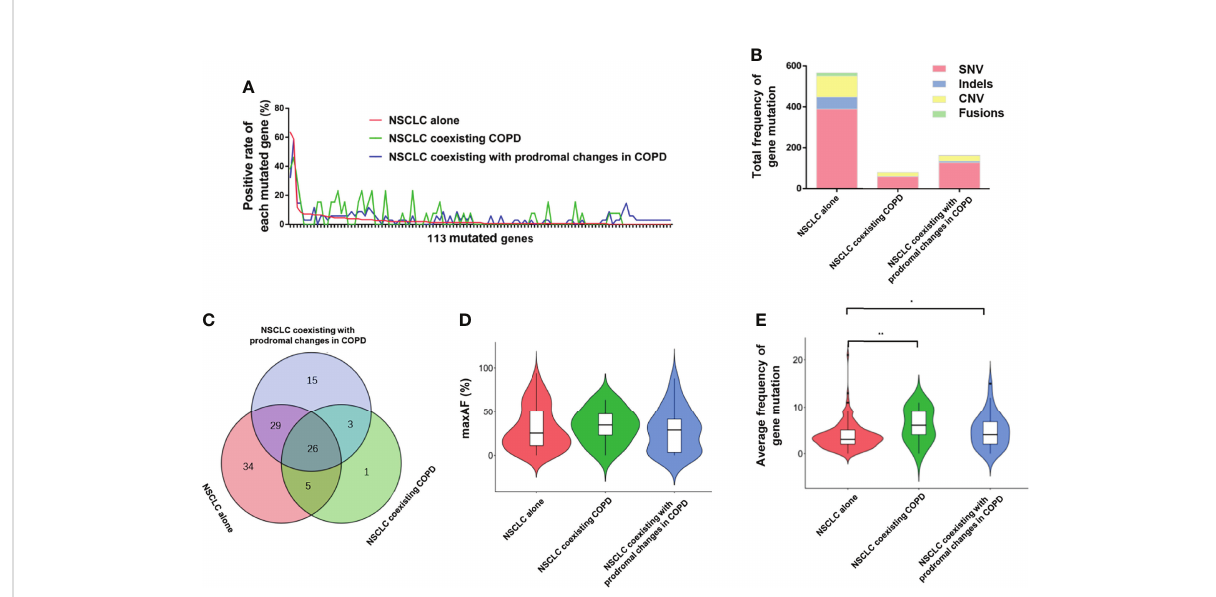
FIGURE 2 Comparison of FFPE tDNA mutations between the NSCLC alone, NSCLC coexisting with COPD and NSCLC coexisting with prodromal changes in COPD groups. (A) The positive rate of each mutated gene in the 113 mutated genes. (B) Total frequency of gene mutation and the proportion of each mutated type. (C) Venn diagram of mutated genes among the three groups. (D) A violin plot of the average maxAF. (E) A violin plot of the average frequency of gene mutation.